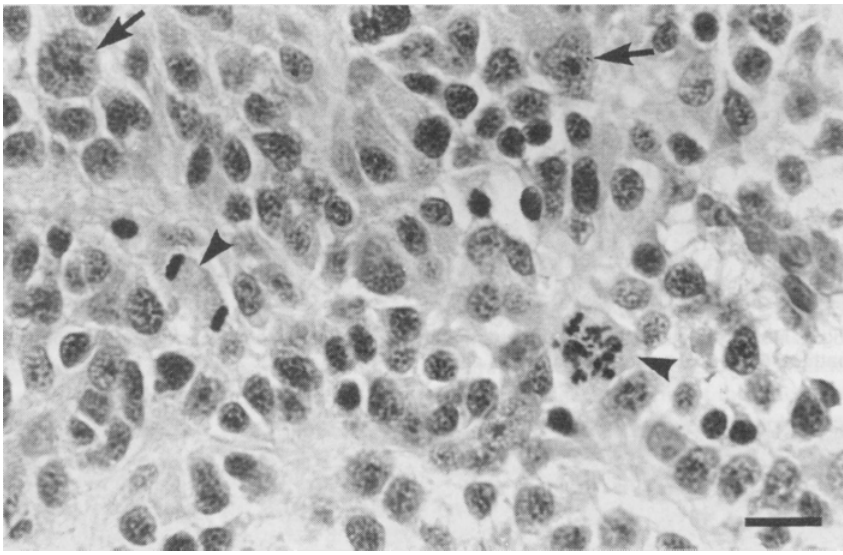
Fig. 4: Meningotheliomatous meningioma. Mitotic figures; one bizarre (arrowheads) and occasional neoplastic cells with a single large pleomorphic nucleus (arrows). Bar = 10 µ m. Haematoxylin and